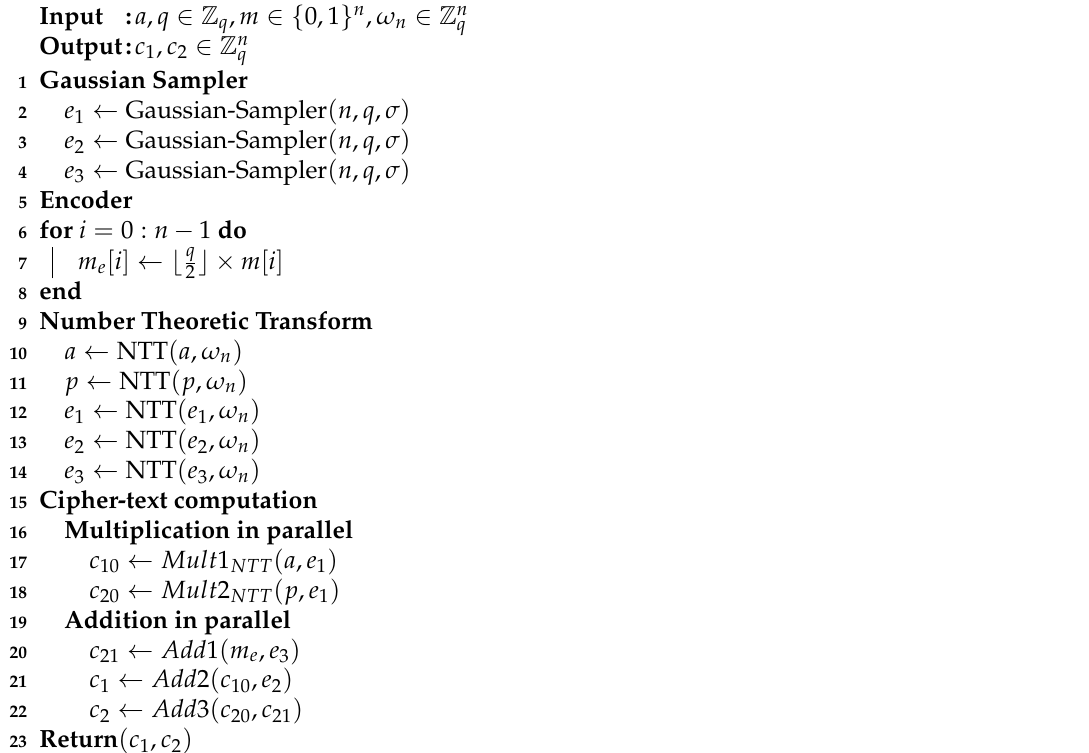
Algorithm 2: Ring-learning with errors (LWE) encryption